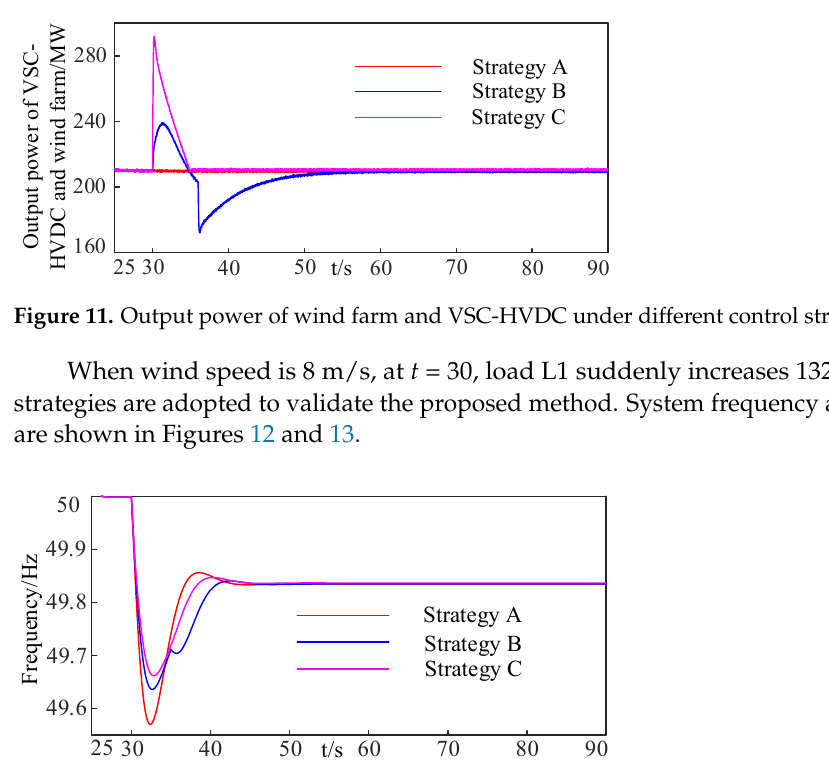
Figure 10. Output active power of DFIG under different control strategies.